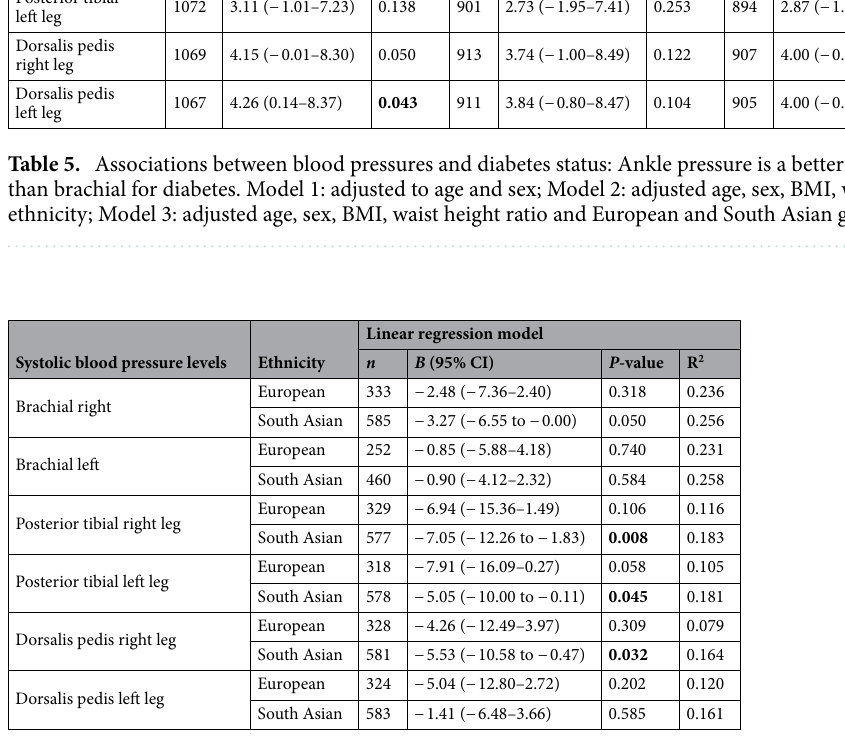
Table 6. Associations between blood pressures and cardiovascular disease status in European and South Asian populations: Ankle pressure is a better determinant than brachial pressure for cardiovascular disease, after adjusted for ethnicity. Blood pressure levels adjusted to age, sex, BMI and waist height